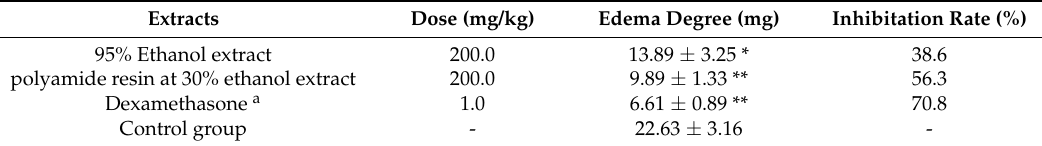
Table 2. Effects of the plant extracts on ear edema induced by croton oil in mice ( n = 3).